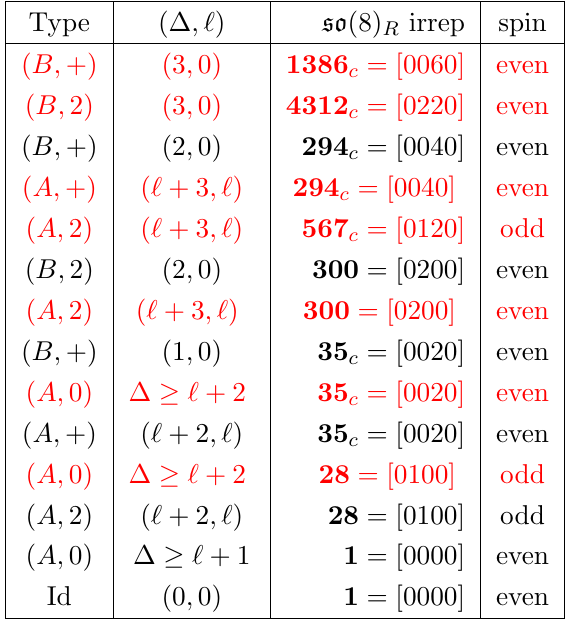
Table 2 . The possible superconformal multiplets in the S 2 (cid:2) S 2 and S 3 (cid:2) S 3 OPEs, where red denotes the multiplets that do not appear in S 2 (cid:2) S 2 . The so (3 ; 2) (cid:8) so (8) R quantum numbers are those of the superconformal primary in each multiplet.